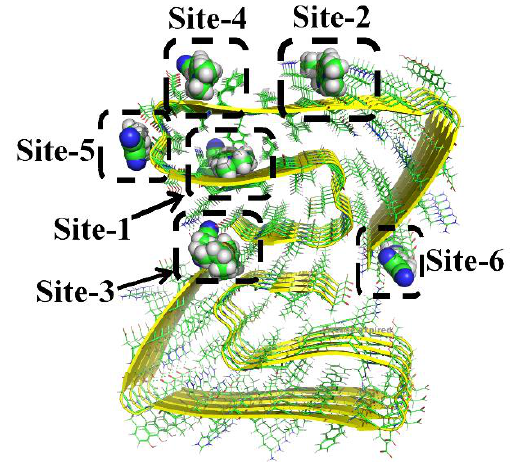
Figure 2. Detailed binding sites for a probe in β -amyloid ( a ) Site-1, ( b ) Site-2, ( c ) Site-3, ( d ) Site-4, ( e ) Site-5, and ( f ) Site-6. The fibril is shown in cartoon mode, and some important residues are shown in stick mode. Clustering of multiple binding sites with binding energy for each binding mode is collected in Figure 3a. It shows that the binding free energies of the probes with A β fibril in Site-1 are much lower than that in other sites, which is due to the fact that they interact with more residues in the core site than the surface or the interfacial sites. Computed from the molecular docking results, the binding energies for probe 1 in Site-1 to Site-4 are − 7.88, − 4.87, − 4.04, − 5.11 kcal/mol, respectively, suggesting various interactions between the ligand and the fibril in different binding sites. The corresponding inhibition constants are 1.67, 268.95, 1100, and 180.81 μ M in the simulation, while the experimental dissocia- tion constant (K d ) has been reported to be 1.95 μ M, indicating that Site-1 is probably re- sponsible for the probe binding in nature. Thus, one can judge that Site-1 is the dominant binding site, while other binding sites play incidental roles. For each series of the inves- tigated probe in the same site, the binding energy is much lower for the probe with a longer polyene chain than that with a shorter chain. For example, binding energies for probes 1 to 5 in Site-1 are − 7.88, − 9.08, − 9.88, − 11.01, and − 11.73 kcal/mol, respectively; and, for probes 6 – 8, the values are − 7.53, − 8.66, and − 9.46 kcal/mol, respectively. This is in